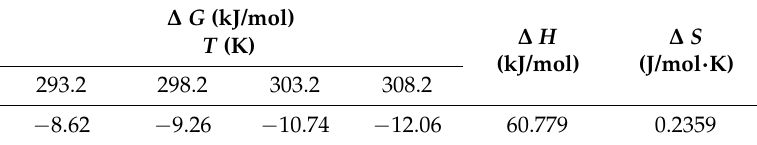
Table 5. The parameters of thermodynamics for the Pb(II) adsorption process on